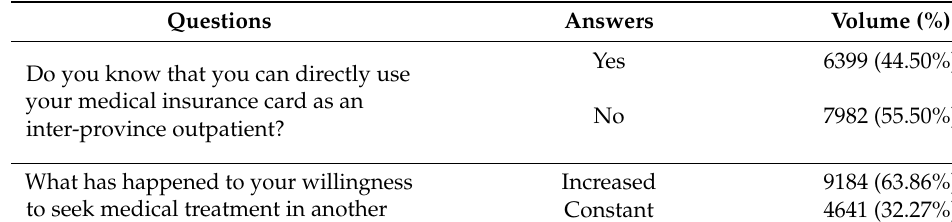
Table 3. Questionnaire survey around trans-provincial medical